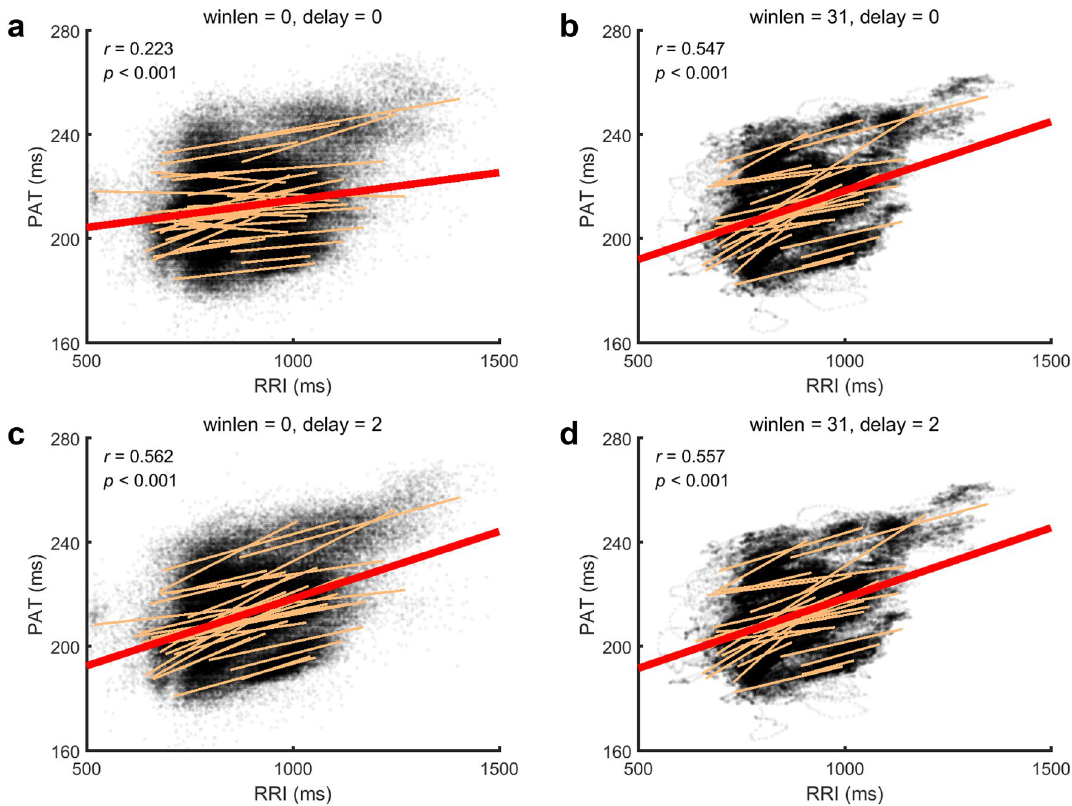
Figure 4. Scatter plots and linear regressions of RRI versus PAT for all subjects in the natural state. The thin yellow lines are the regression lines for individual subjects. The thick red lines are the regression lines for all subjects. winlen, the window length of the Savitzky-Golay filter (winlen = 0, no smoothing). delay, the delayed beats of RRI series. r, the correlation